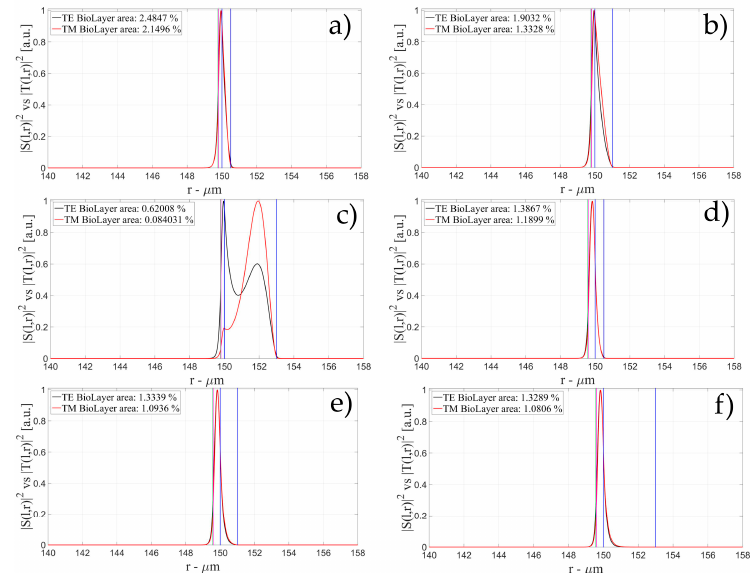
Figure 8. Electric field distribution of WGMs along the radial direction for TE (| S ( l,r ) | 2 ) and TM (| T ( l,r ) | 2 ) modes for the 1st radial order: ( a ) for a wall of about 500 nm and a polymer thickness of about 200 nm; ( b ) for a wall of about 1 μ m and a polymer thickness of about 200 nm and ( c ) for a wall of about 3 μ m and a polymer thickness of about 200 nm; ( d ) for a wall of about 500 nm and a polymer thickness of about 400 nm; ( e ) for a wall of about 1 μ m and a polymer thickness of about 400 nm and ( f ) for a wall of about 3 μ m and a polymer thickness of about 400 nm. Legends show the fraction of | S ( l,r ) | 2 and | T ( l,r ) | 2 inside the biological layer.